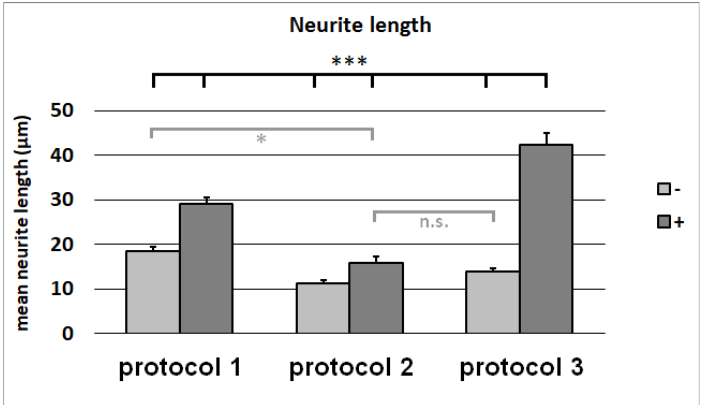
Figure 9. Lengths of neurites in µ m on NG108-15 cells after cultivation with media from Protocols 1, 2, and 3, with (+) and without ( − ) conditioning with predifferentiated ASCs. The mean value and standard error of the mean for each condition are shown. The differences between every two conditions are statistically highly significant, except for Protocol 2 + NGF, which differs from Protocol 1, without NGF being statistically significant, and does not statistically significantly differ from Protocol 3 without NGF. n.s.: not significant; *: p -value < 0.05; ***: p -value < 0.001.